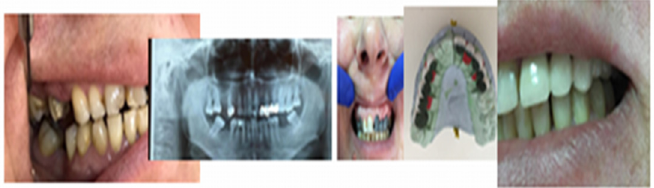
Figure 13. Images of the initial clinical situation, paraclinical orthopantomography examination, and the occlusal rehabilitation for the necessary foundation of the stomatognathic system homeostasis.